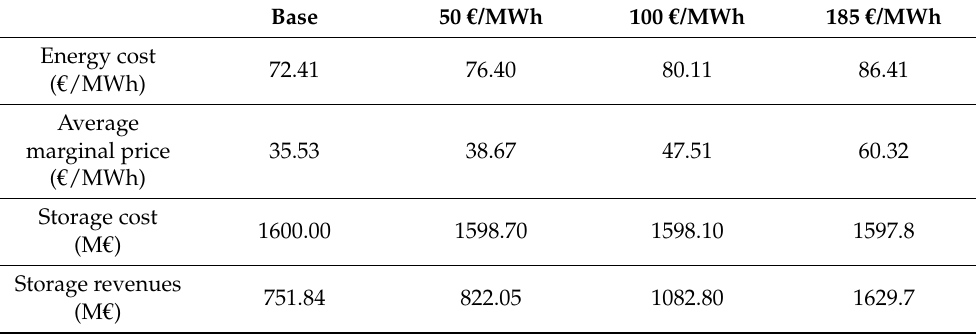
Table 8. Cost of energy and storage for different CO 2